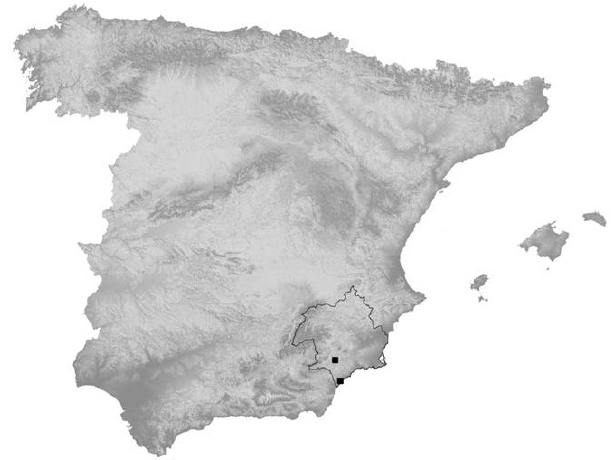
Fig 1 . Map of Spain with the location of the Segura river basin outlined and the two localities with Temnothorax ansei sp.n. indicated with black squares.